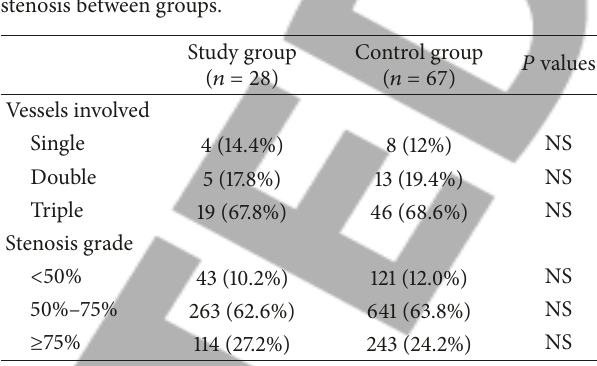
Table 2: Comparison of coronary lesions and degree of coronary stenosis between